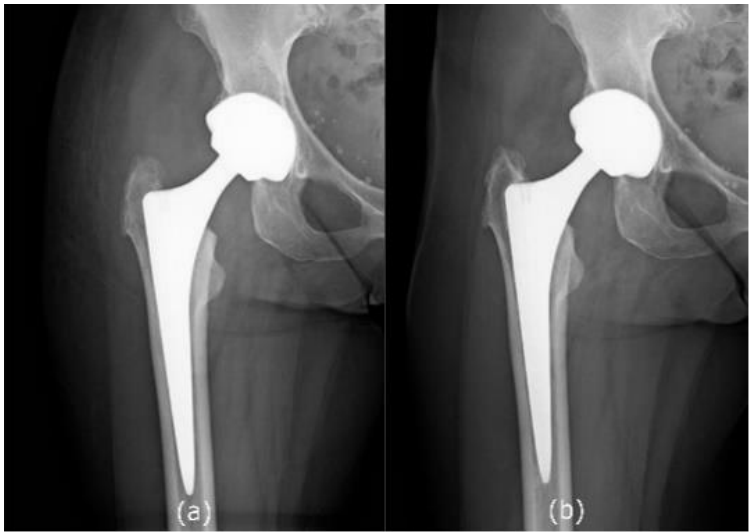
Figure 4. V.D., female, 58 - year-old, Ceramic-on-Ceramic Total Hip arthroplasty for femoral neck fracture, right hip X-ray: ( a ) Post-operative follow-up, one month ( b ) Post-operative follow-up, 5 years (24 months after recruitment).